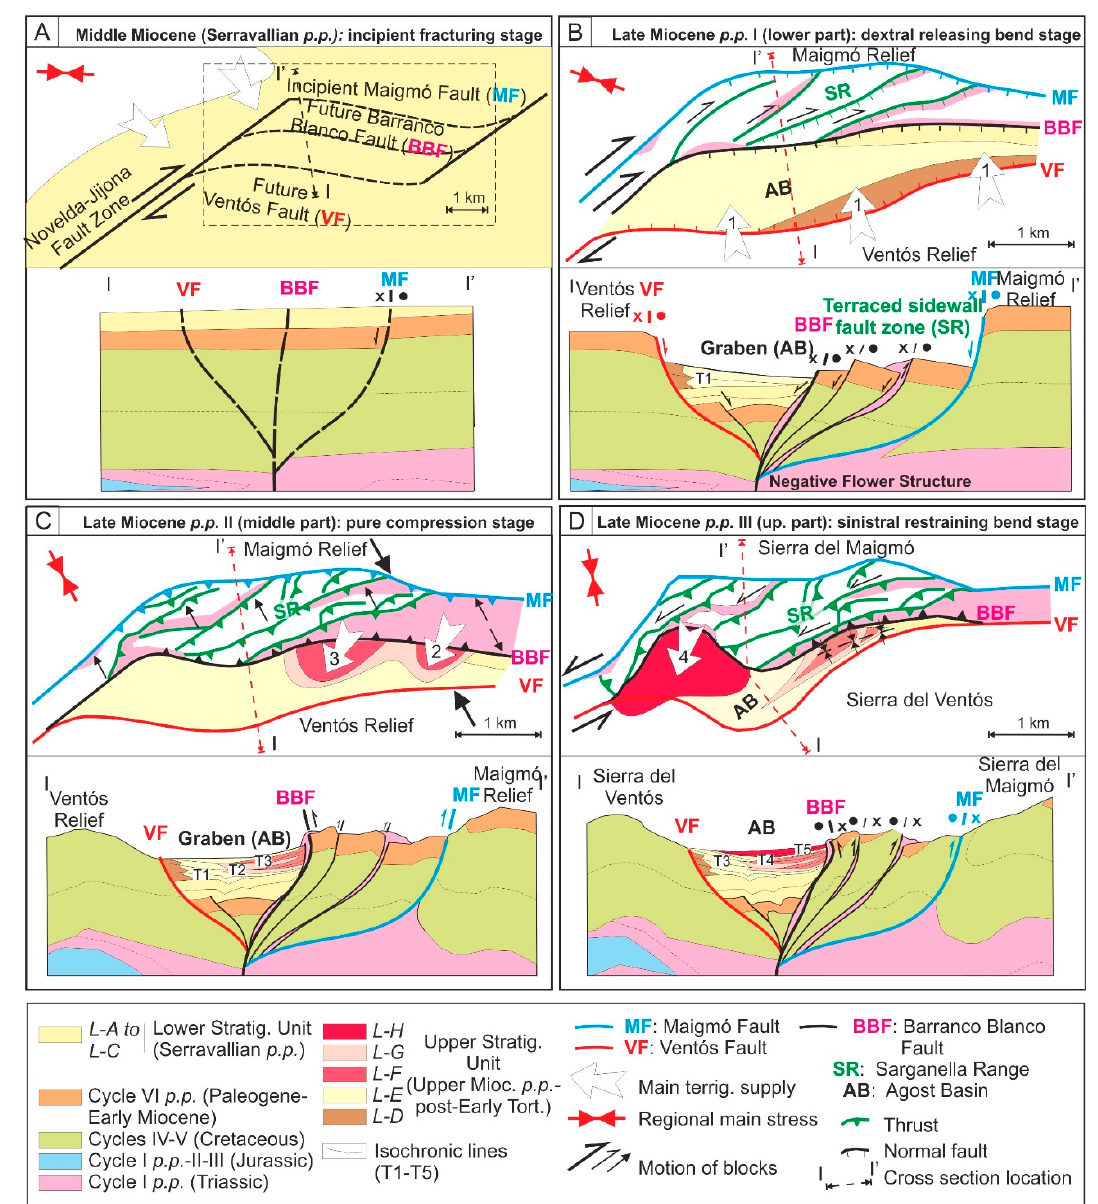
Figure 11. Neogene tectono-sedimentary evolution of the Agost Basin (Alicante province) of the eastern EBZ (after Reference [21]; modified). The main regional stress, motion of blocks, faults’ actuation and main terrigenous supply is represented. ( A ) paleogeographic sketch map and section of the Serravallian, ( B , C , D ) paleogeographic sketch maps and sections of the Late Miocene.